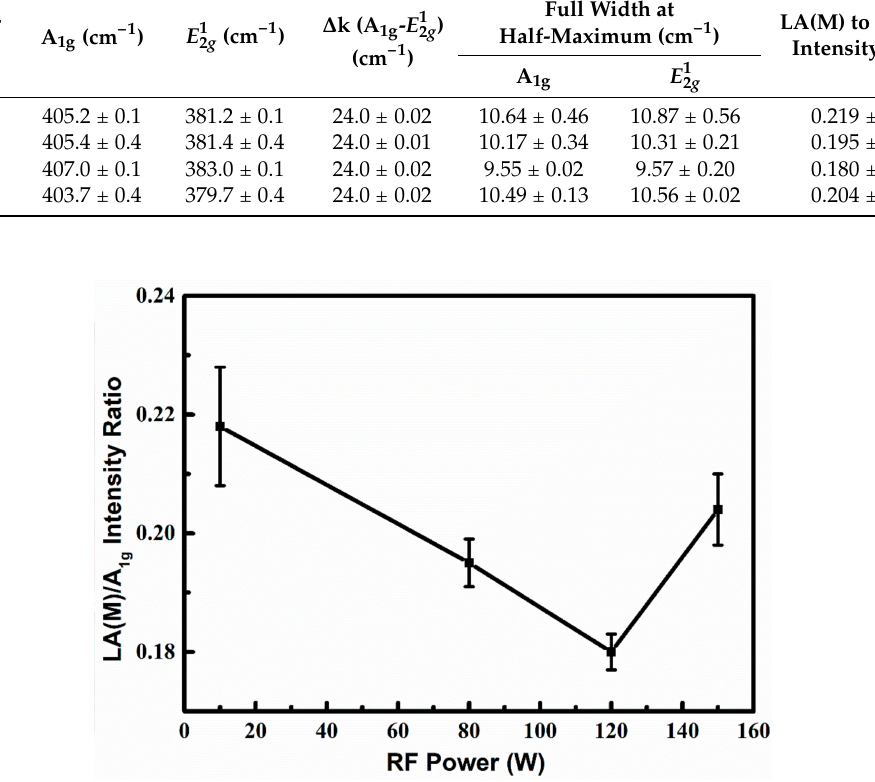
Figure 3. LA(M) to A 1g peak intensity ratio of the MoS 2 films with different RF powers deposited on SiO 2 /Si